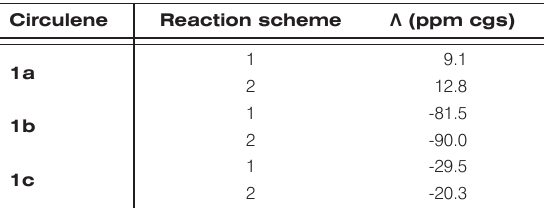
Circulene Reaction